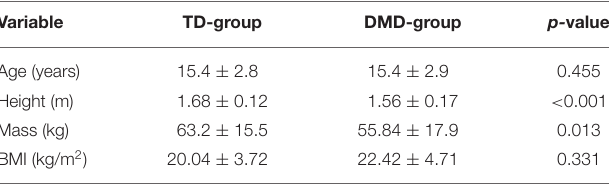
TABLE 2 | Values (mean ± standard deviation) of age, height, mass, and body mass index (BMI) for both TD and DMD groups. Variable